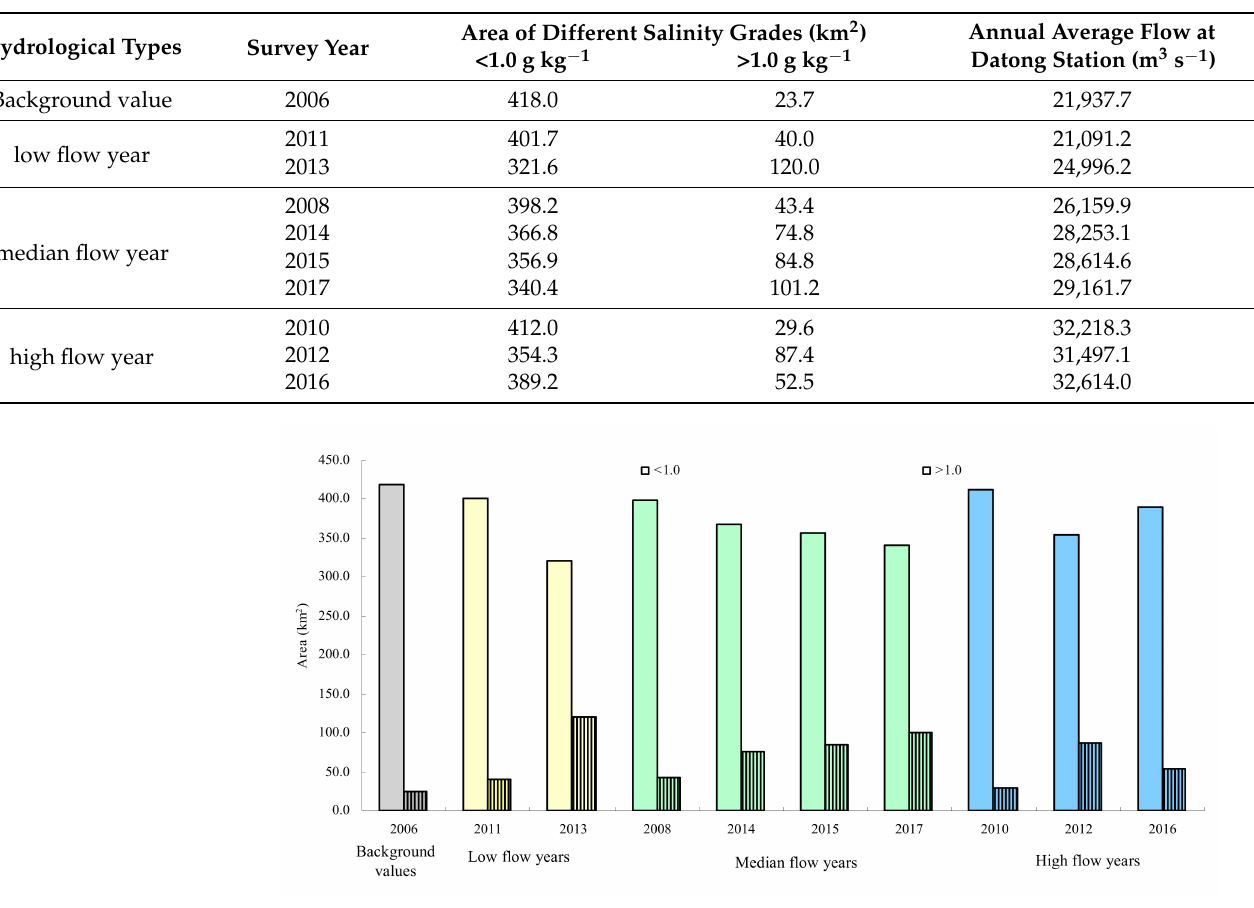
Figure 10. Area of salt affected soil